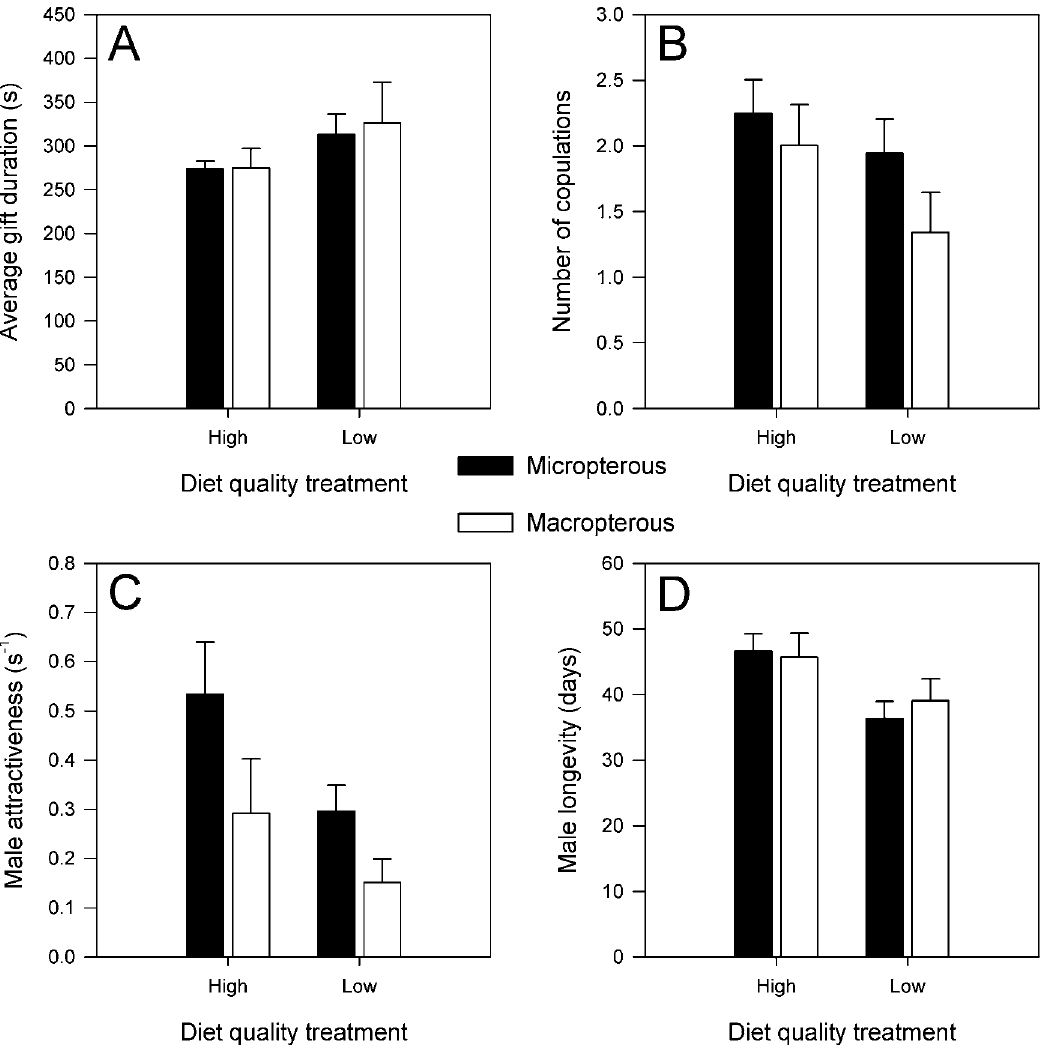
Figure 1. The effect of diet quality treatment and wing morph type on male reproductive investment. The means and standard errors for the diet treatment and wing morph factors are calculated based on the average values for each of the experimental populations.